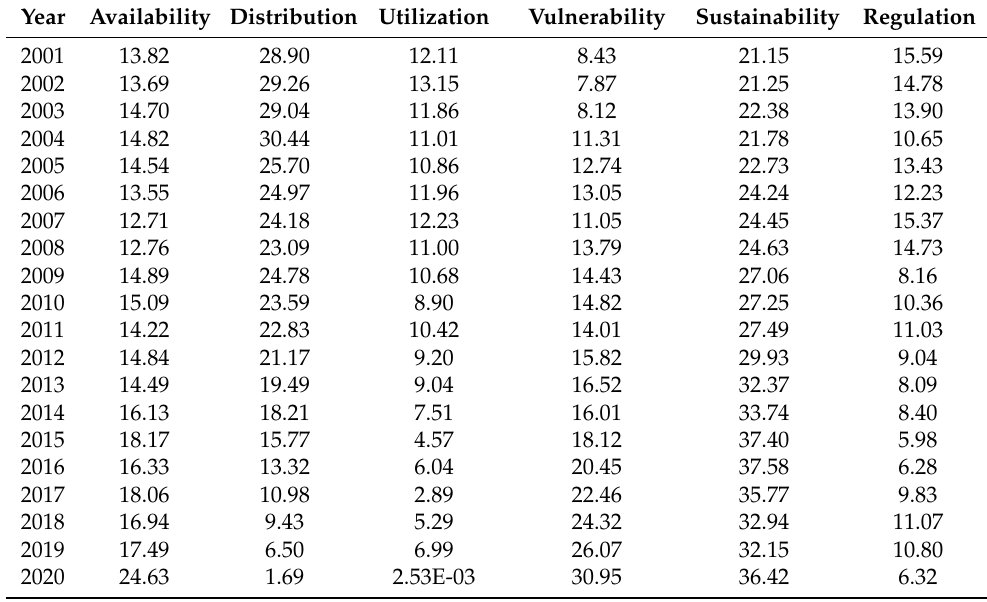
Table A2. Obstacle degree of six units relating to China’s food security during